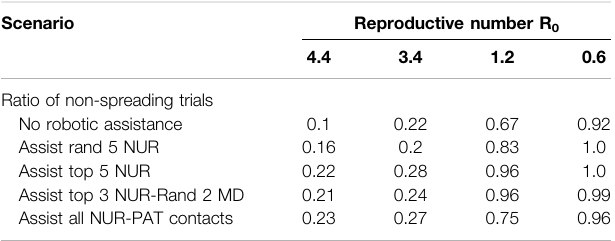
TABLE 2 | Results for the probability of pathogen spread across the network for different reproductive numbers.